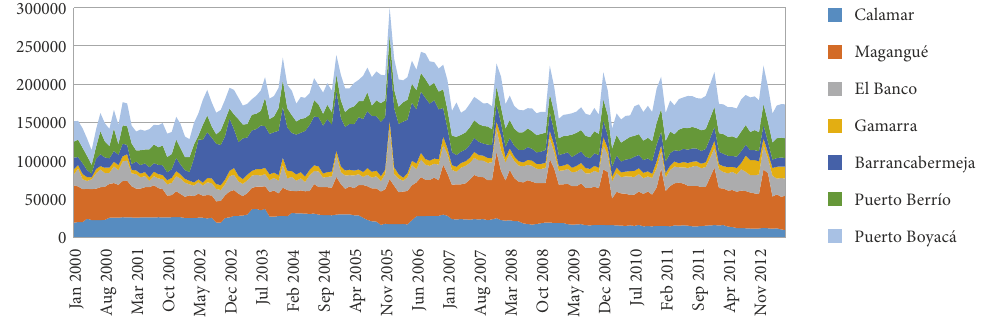
Figure 2. Number of passengers at ports per month